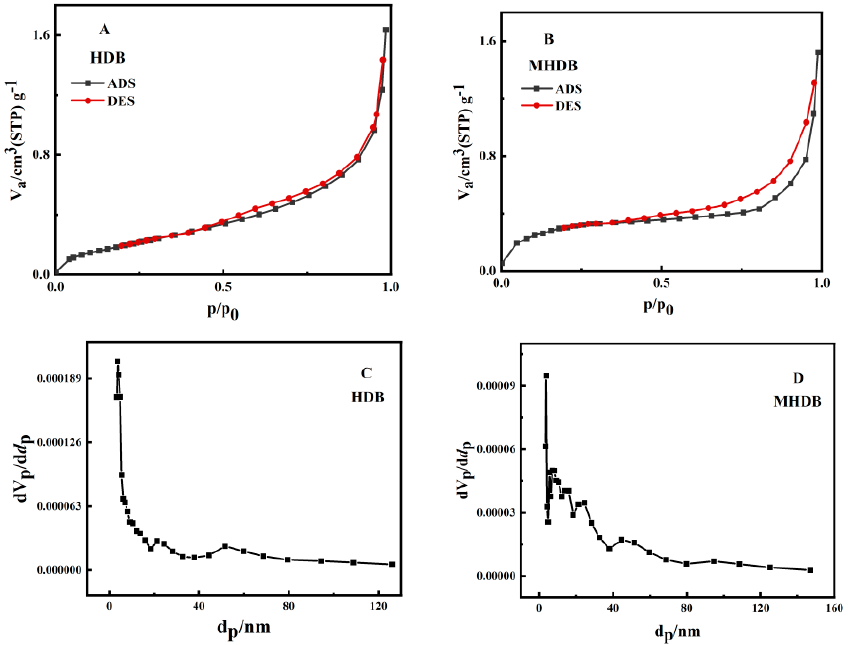
Figure 2. Nitrogen physisorption–desorption isotherms of HDB ( A ) and MHDB ( B ); BJH mesopore size distributions of HDB ( C ) and MHDB ( D ).